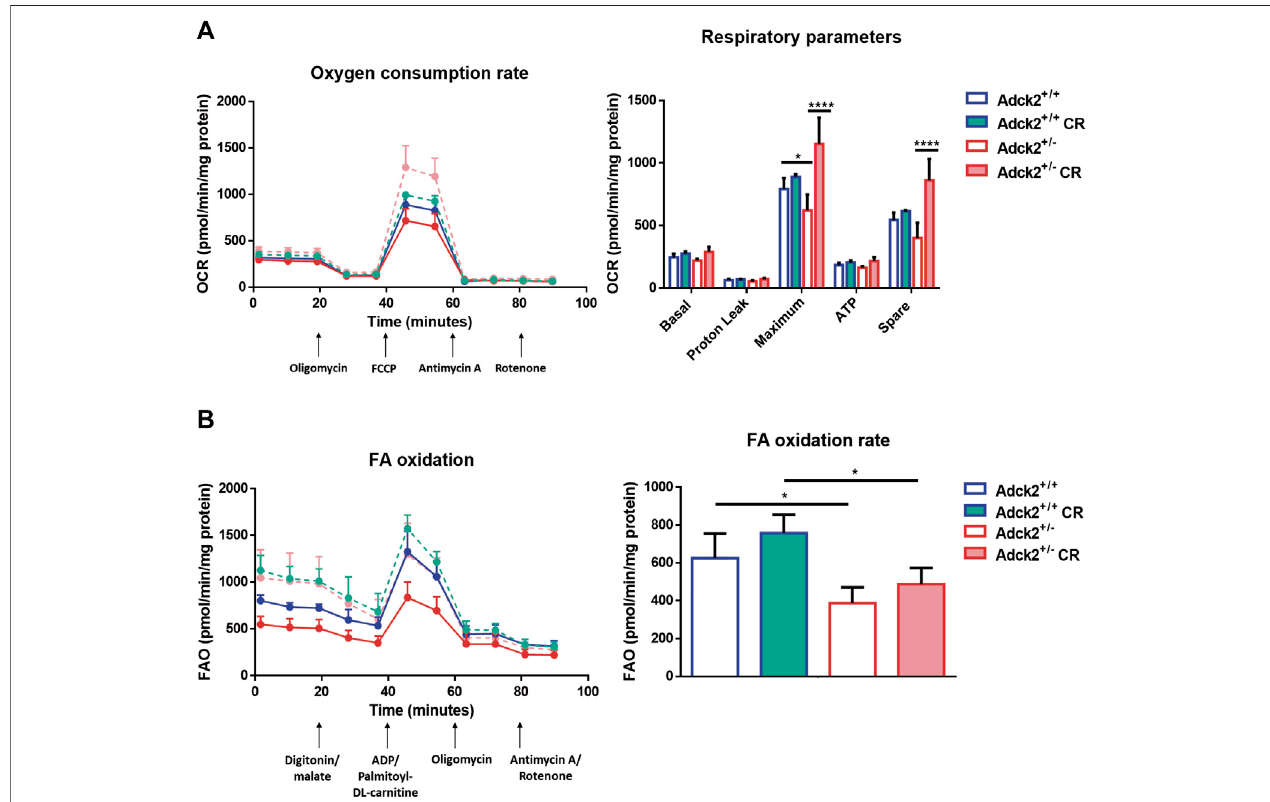
FIGURE 7 | Respiration of satellite cells under calorie restriction conditions. (A) . Oxygen consumption rate in myotubes. (B) . Fatty acids β -oxidation rate in myotubes. FA β -oxidation rateswere obtained subtracting the two measures post digitonin/malate injection tothe twomeasures post ADP/palmotoyl-DL-carnitine One representative experiment of two independent experiments in shown for each assay. FA, fatty acids; FAO, fatty acids oxidation; OCR, oxygen consumption rate; FCCP, Carbonyl cyanide-p-tri fl uoromethoxyphenylhydrazone; CR, calorie restriction. Data represent the mean ± SD. Two-way ANOVA test was applied. * p < 0.05; ** p < 0.01; *** p < 0.001; **** p <